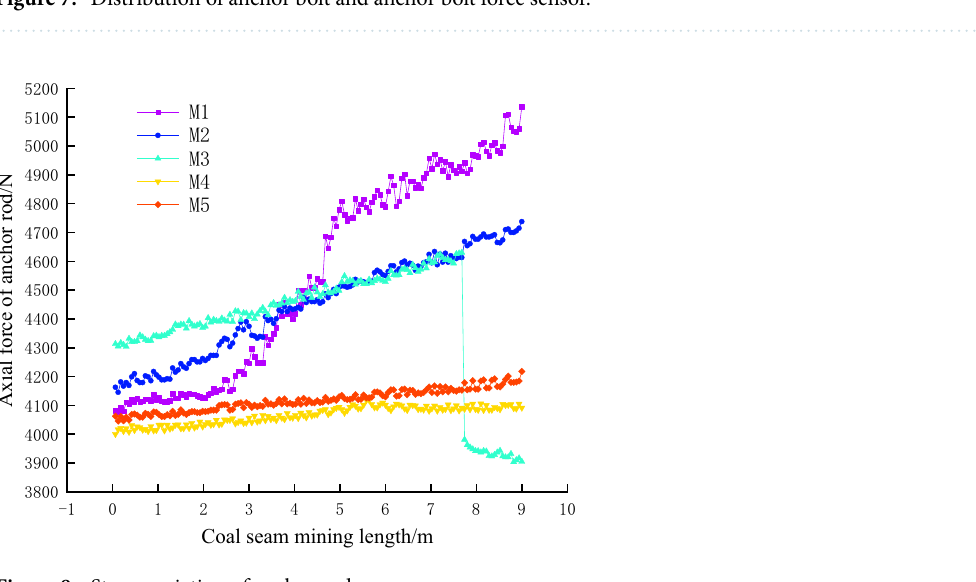
Figure 8. Stress variation of anchor